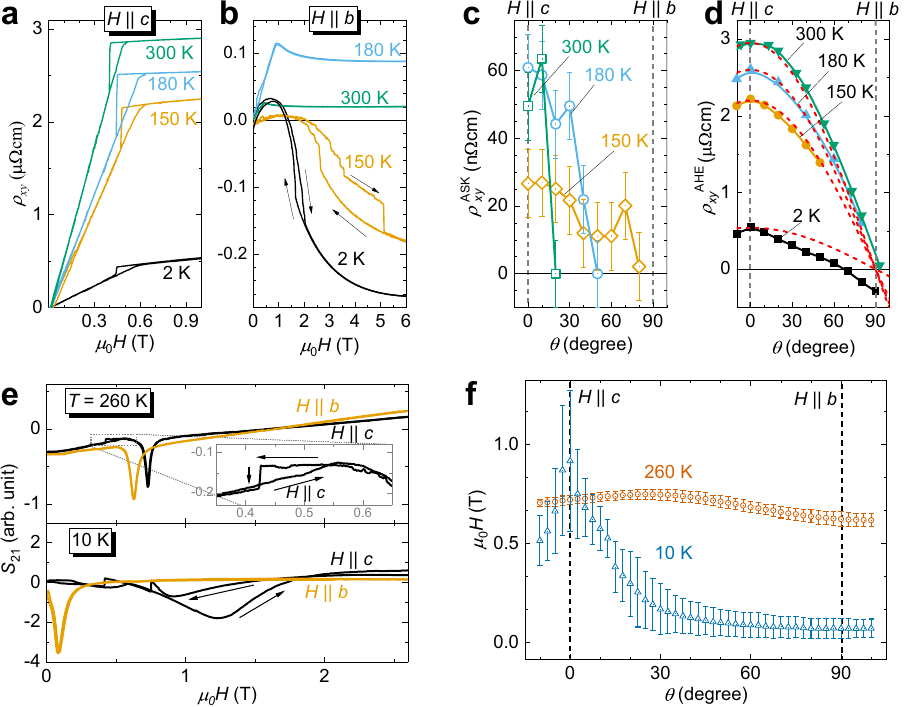
Fig. 4 Angle-dependent Hall and FMR at various temperatures. a , b ρ xy (H) of device B with 1 μ m thickness recorded for H ∥ c and H ∥ a , respectively, at various temperatures. c Extracted ASK Hall signature at three fi xed temperatures for various angles. The error bars are de fi ned as in Fig. 3c. d Anomalous Hall coef fi cient extracted from linear fi ts to the high- fi eld part above 5 T of ρ xy ( H ) plotted against the tilt angle θ . Red dashed lines are fi ts with ρ ð H Þ / cos θ . e , f FMR forward-transmission parameter, S H ∥ c and H ∥ b recorded for a 0.8 μ m thick lamella at 10 and 260 K. f Angular xy 21 . e FMR spectra for dependence of the FMR fi eld. Error bars represent the resonance linewidth